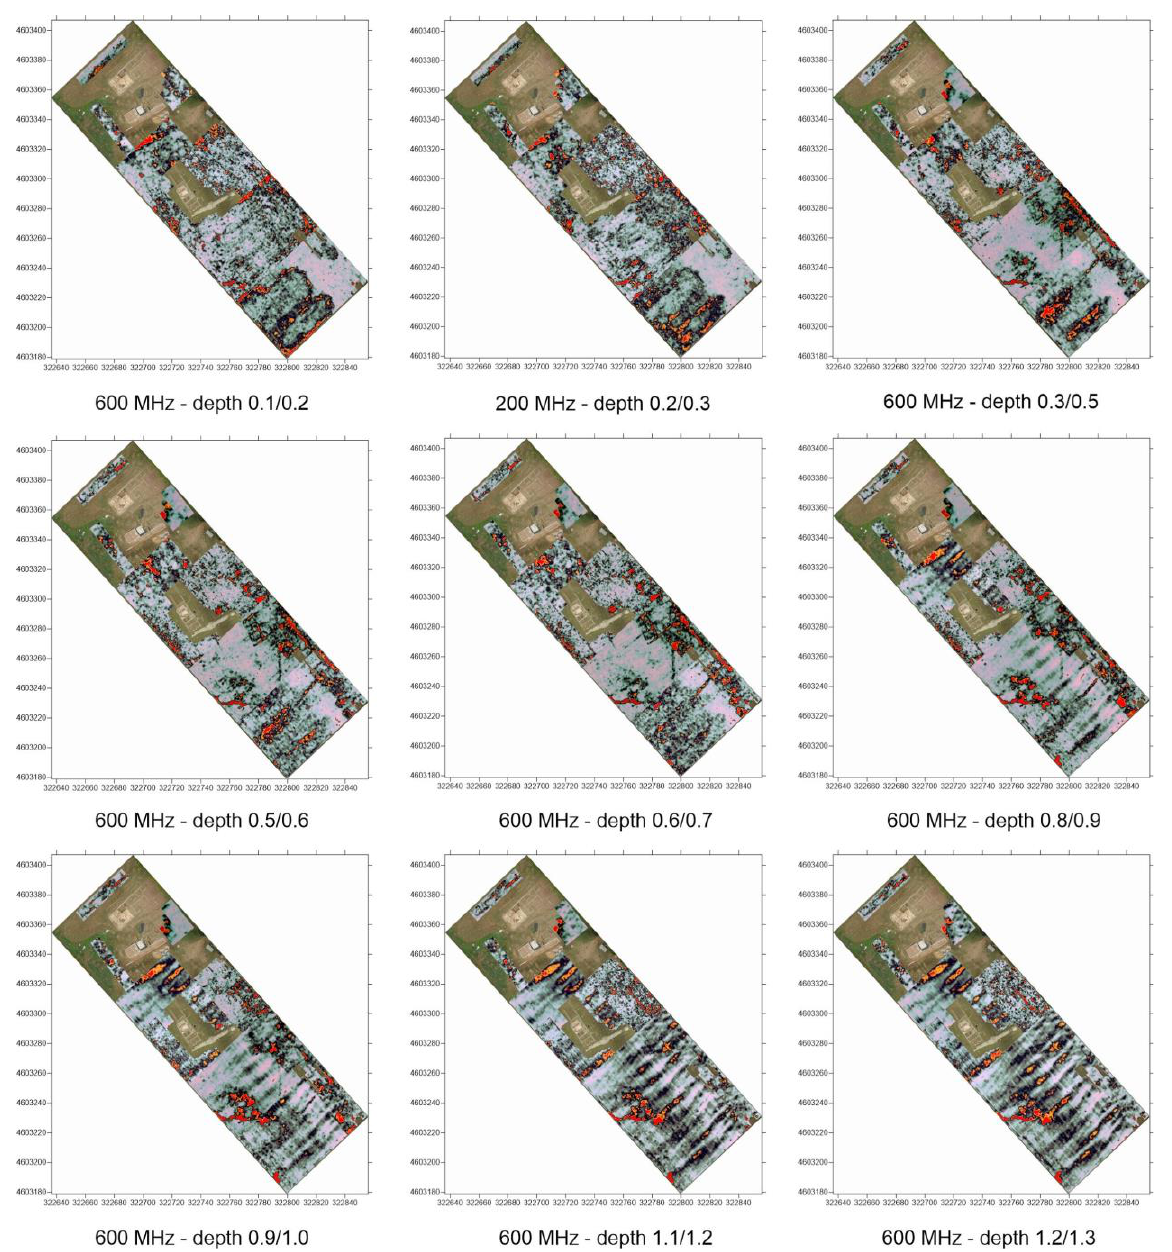
Figure 15. Selection of time slices collected with 600 MHz